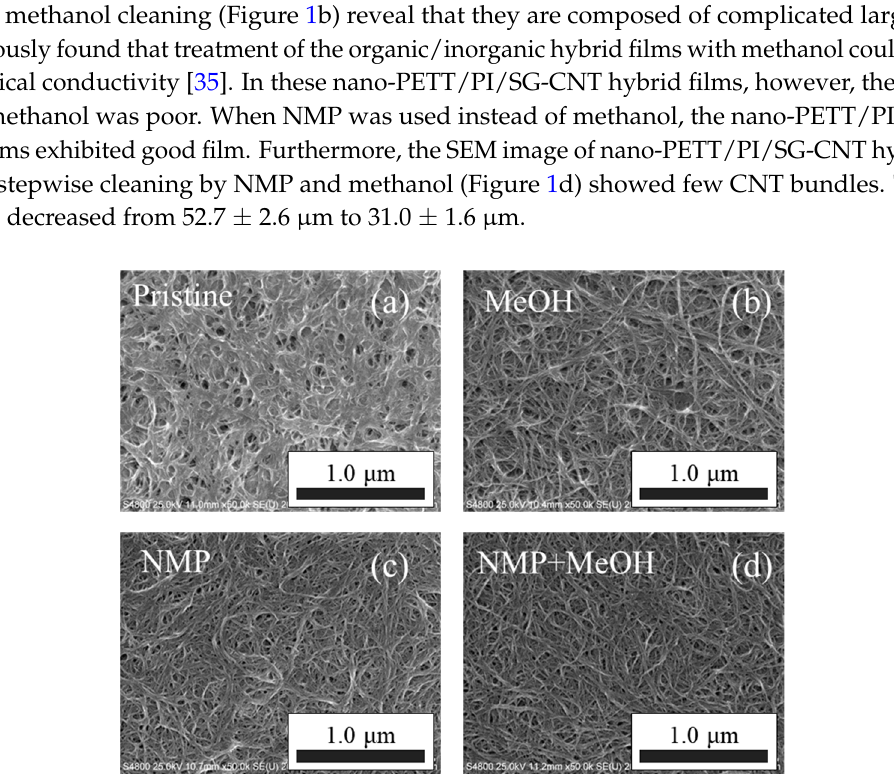
Figure 1. SEM images of the hybrid films of nano-PETT/PI/SG-CNT before cleaning ( a ), after methanol cleaning ( b ); after N -methylpyrrolidone (NMP) cleaning ( c ) and after the stepwise cleaning by NMP and methanol ( d ).